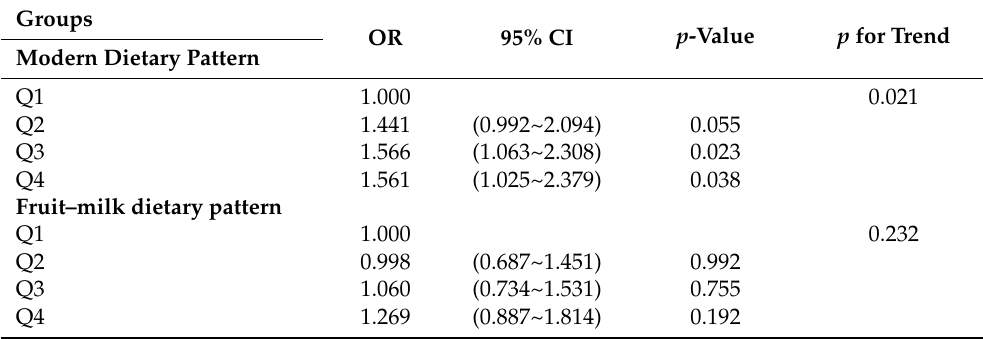
Table 2. Odds ratios (95% confidence intervals) for high blood glucose across quartiles of dietary